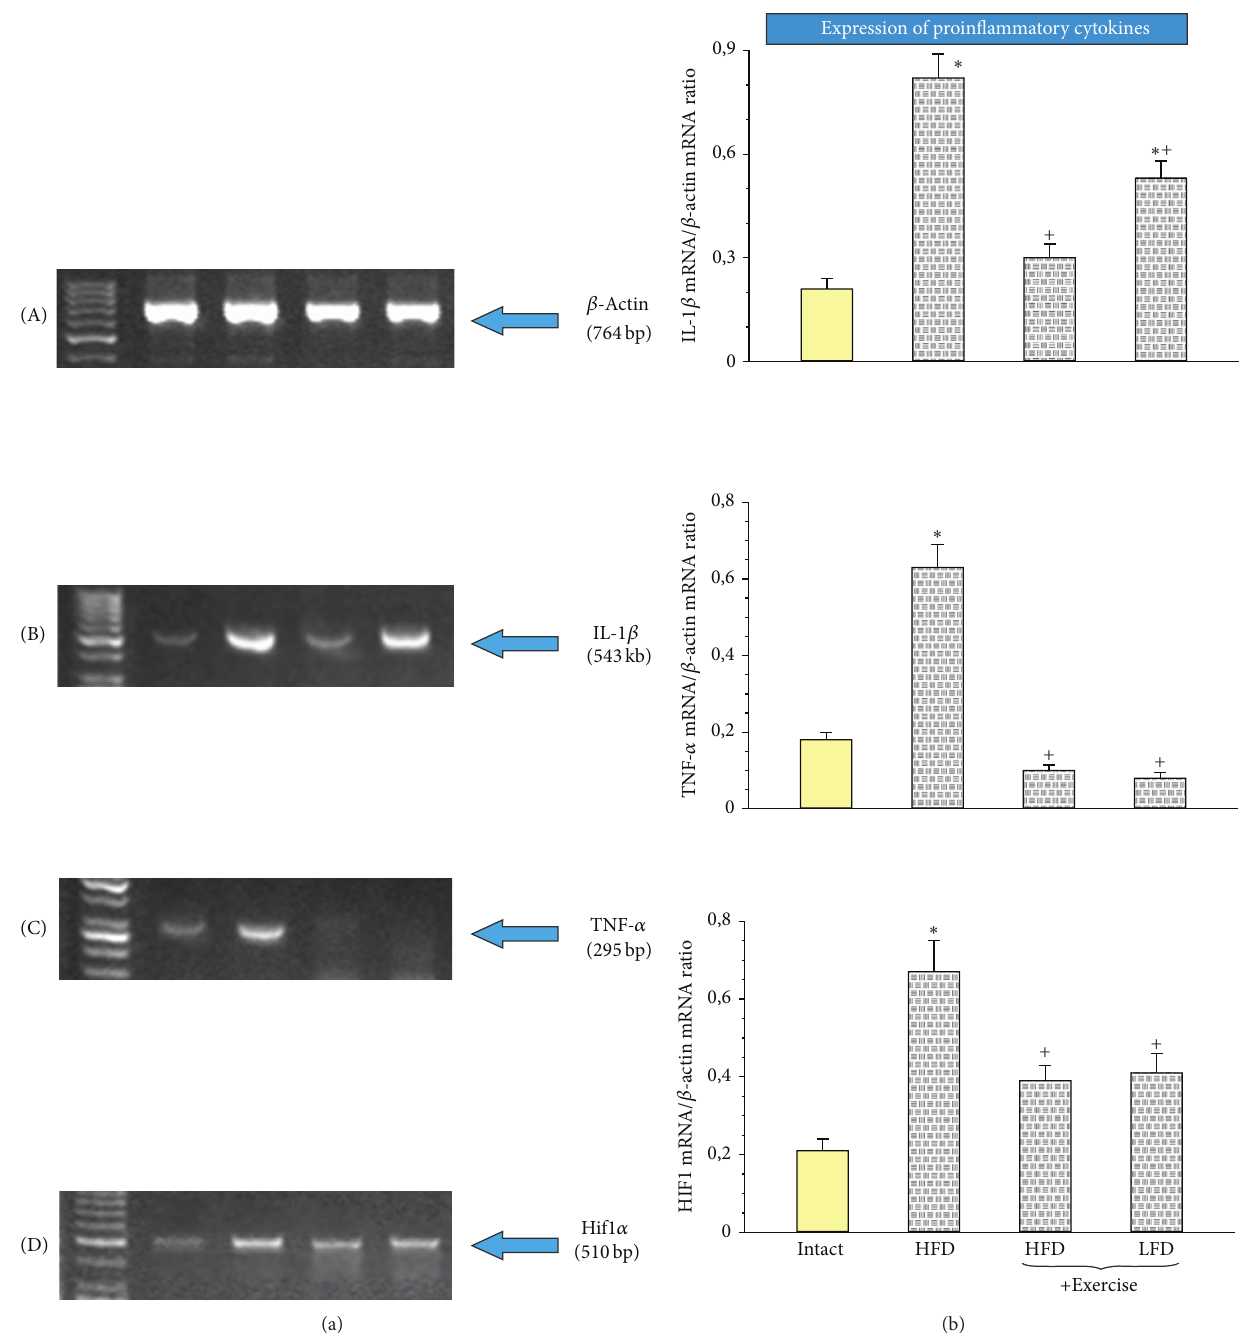
Figure 8: The RT-PCR analysis of mRNA expression for 𝛽 -actin (A), IL-1 𝛽 (B), TNF- 𝛼 (C), and Hif1 𝛼 (D) (a) in colonic mucosa of intact rats or untrained TNBS rats fed HFD or trained TNBS rats fed HDF or LDF and the semiquantitative ratio of IL-1 𝛽 -, TNF- 𝛼 -, and Hif1 𝛼 mRNAs over 𝛽 -actin mRNA (b). Results are mean ± SEM of 4 determinations. Asterisk indicates a significant change ( 𝑃 < 0.05 ) as compared with the values obtained in intact colonic mucosa. Cross indicates a significant change ( 𝑃 < 0.05 ) as compared with untrained rats fed with HFD.